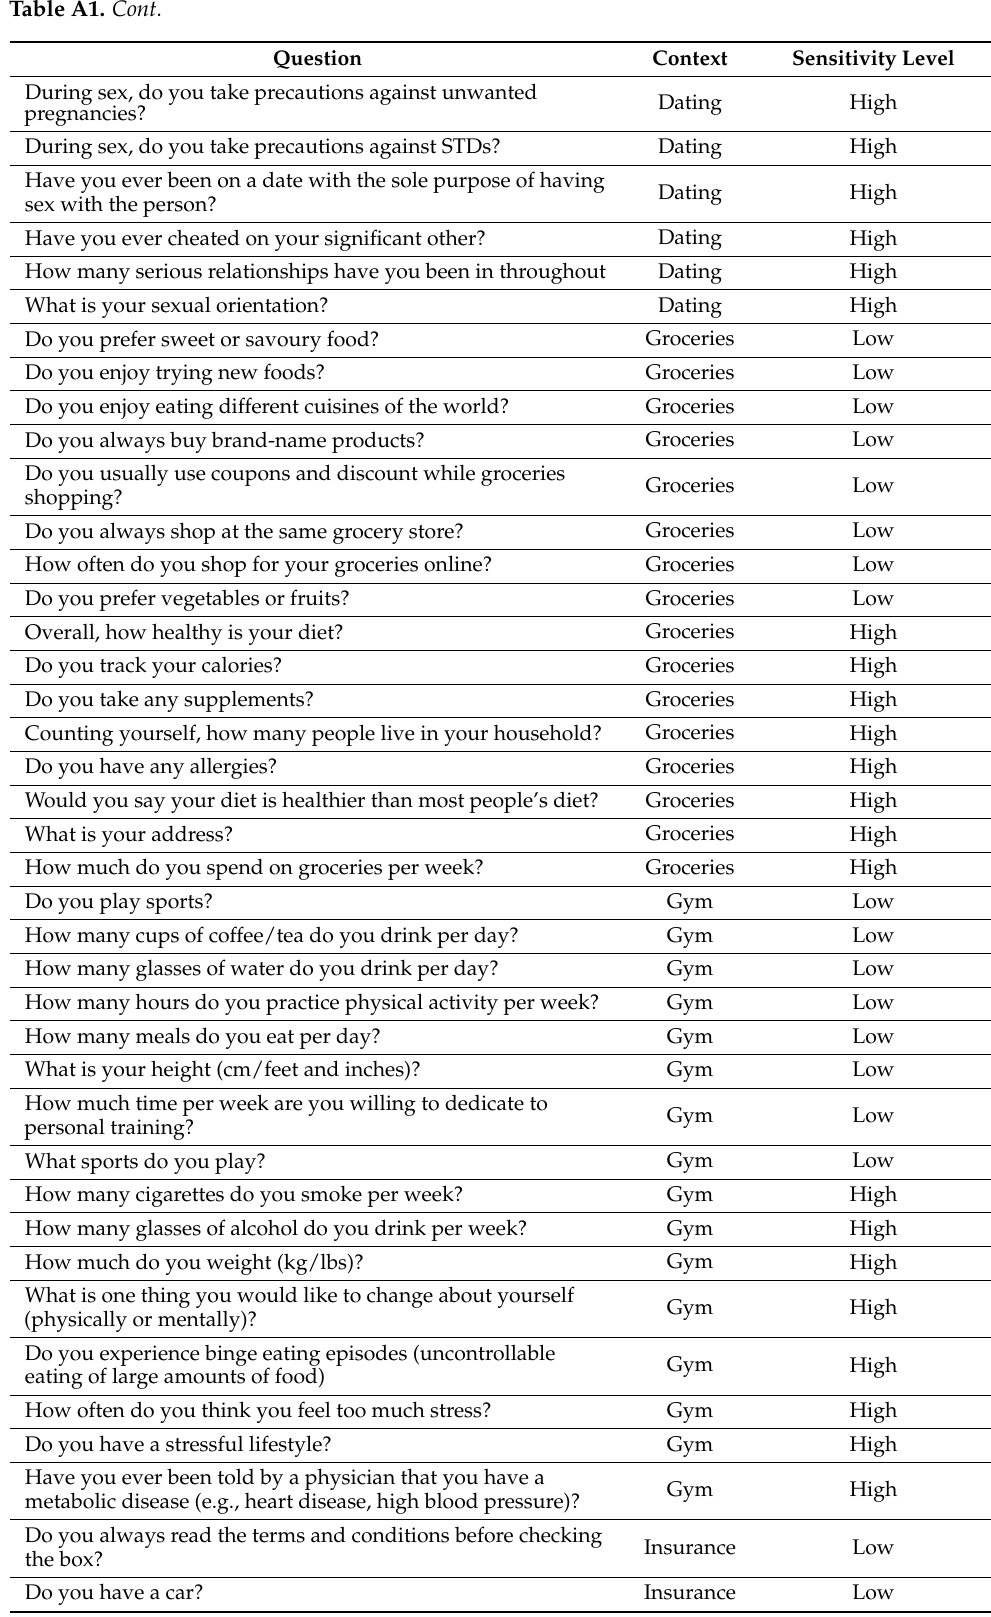
Table A1. Cont. Question Context Sensitivity Level During sex, do you take precautions against unwanted pregnancies?